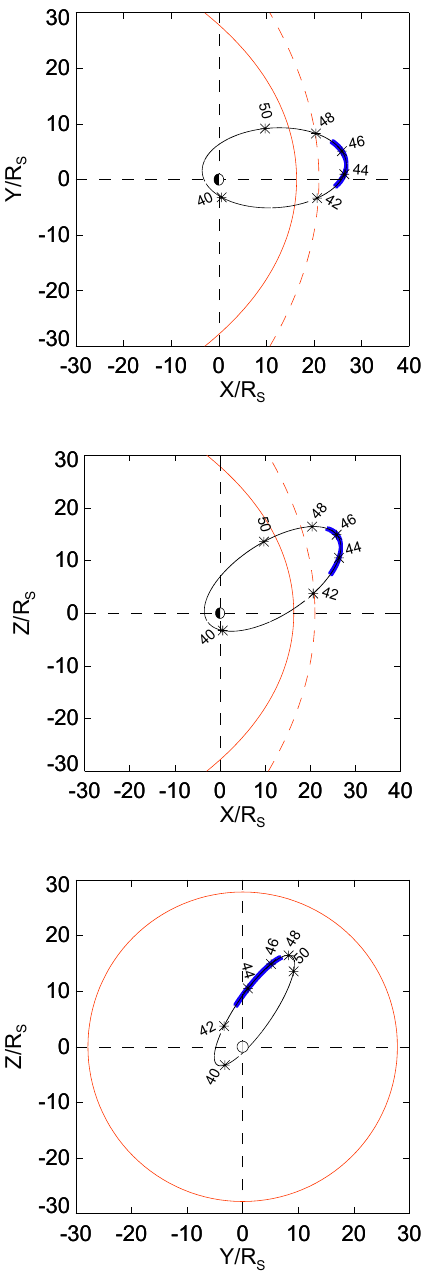
Fig. 1. Trajectory of the Cassini spacecraft in KSM coordinates from near the periapsis of Rev 58 to near the periapsis of Rev 59. The three panels show from top to bottom the trajectory projected onto the X-Y, X-Z, and Y-Z planes, with the position marked by stars at the beginning of each even-numbered day. The intersections of the magnetopause and bow shock with these planes are shown by the solid and dashed red lines, respectively, obtained from the mod- els of Kanani et al. (2010) and Masters et al. (2008) for a solar wind dynamic pressure of 0.1nPa. The blue segment of the trajectory spanning apoapsis corresponds to the interval for which magnetic field data are shown in Fig.